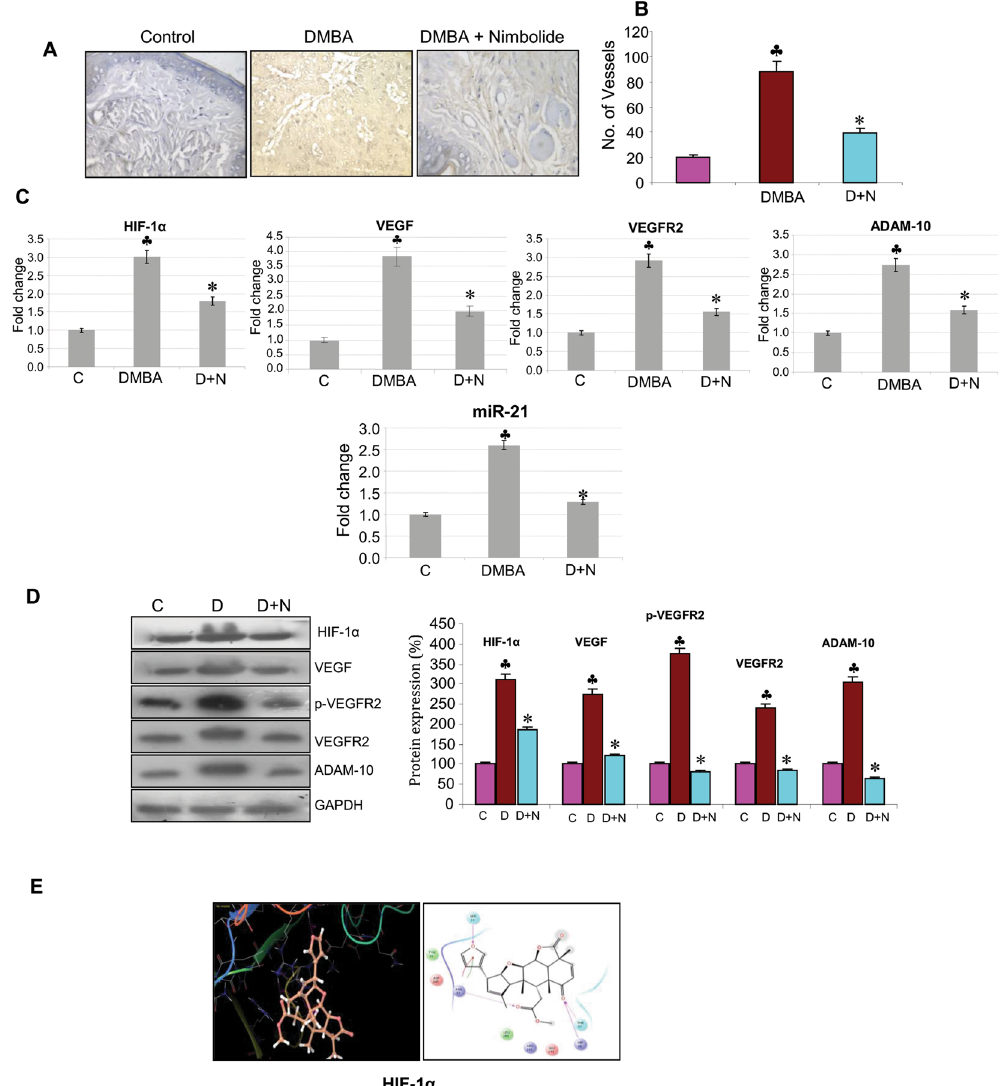
Figure 5. Nimbolide exerts anti-angiogenic effects. ( A ) Microvascular density analysis suggests that nimbolide treatment decreased vessel density (40X). ( B ) Bar graph representing number of vessels (N = 3). ♣ p < 0.001 versus control. * p < 0.001 versus DMBA. ( C ) Transcript expression level of HIF-1 α , VEGF, VEGFR2, ADAM- 10 and miR-21 by quantitative RT-PCR. Data are the mean ± SD of three independent experiments. ( D ) Protein samples were resolved on SDS-PAGE and western blot analysis was performed by probing with corresponding antibodies. Data are the mean ± SD of three independent experiments (N = 3). ( E ) Plausible binding mode